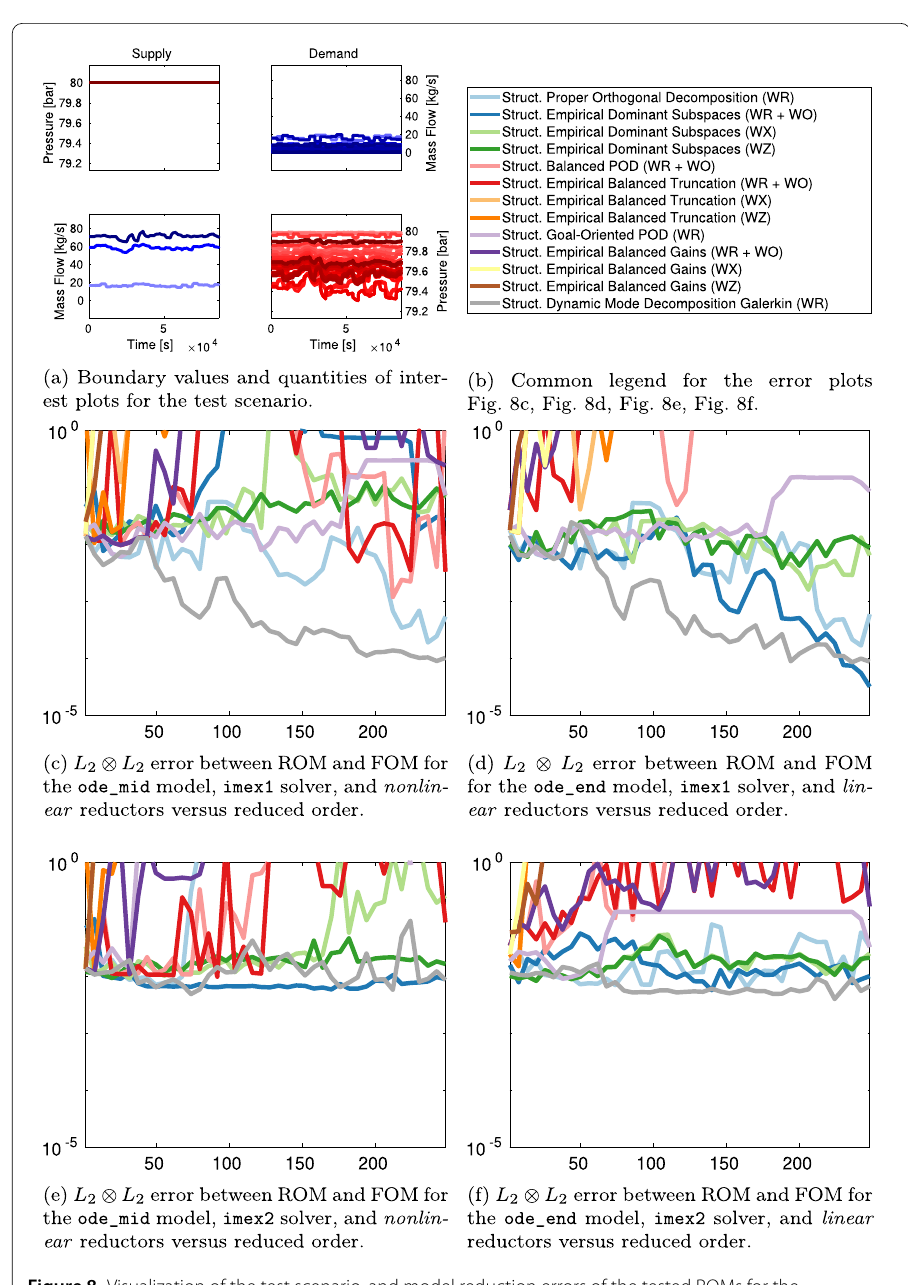
Figure 8 Visualization of the test scenario, and model reduction errors of the tested ROMs for the GasLib-134v2 network from Sect. 6.4